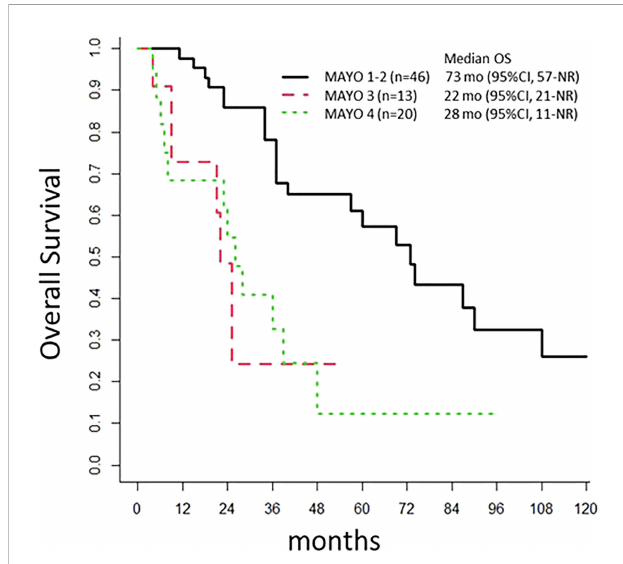
FIGURE 3 Overall Survival. The population of 97 patients with urachal cancer at diagnosis is strati fi ed according to the Mayo classi fi cation. OS, overall survival; mo, months; NR, Not